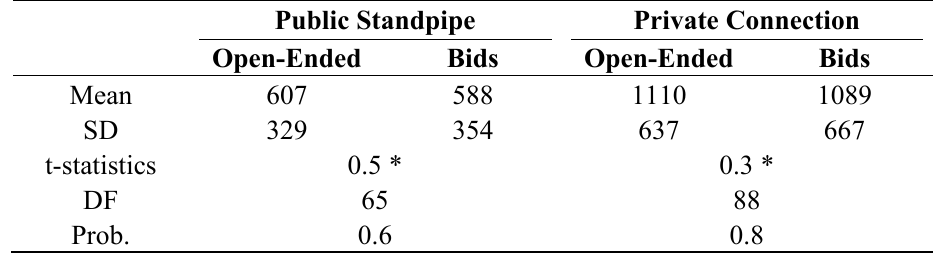
Table 2. Comparing means for open-ended and bids format standardized from 100 to 2000.